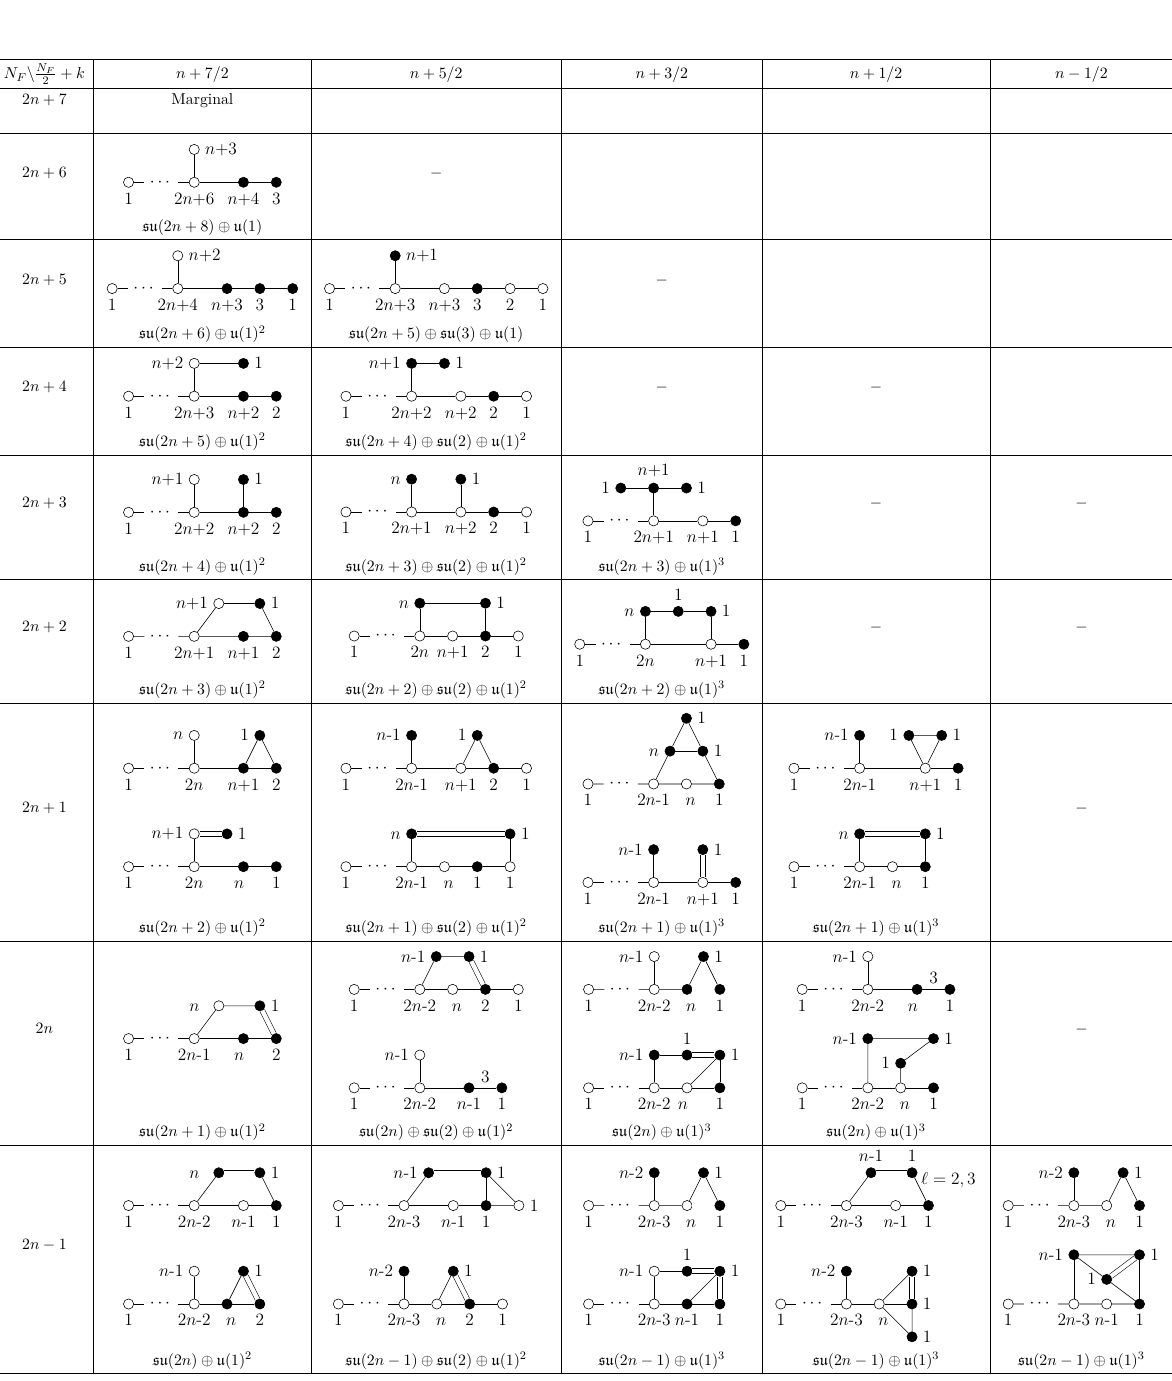
Table 16 . UV-MQs for descendants of SU(2 n + 1) 0 + 1 AS + (2 n + 7) F with N F ≥ (2 n − 2)